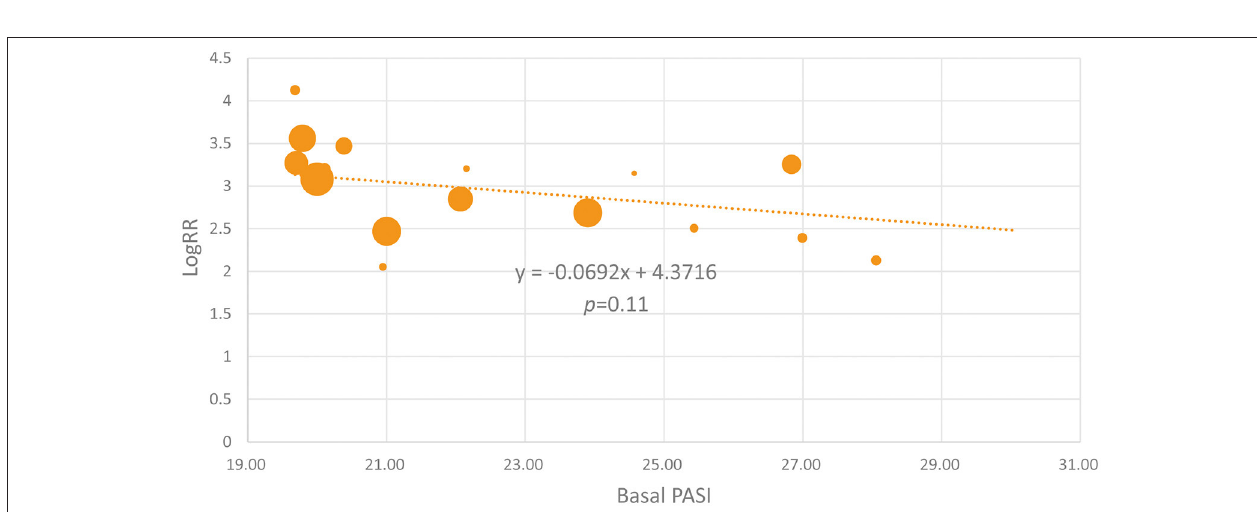
FIGURE 5 | The meta-regression analysis investigating the association of the basal PASI and the logRR treatment effect across studies (the PASI 75 response at week 12).